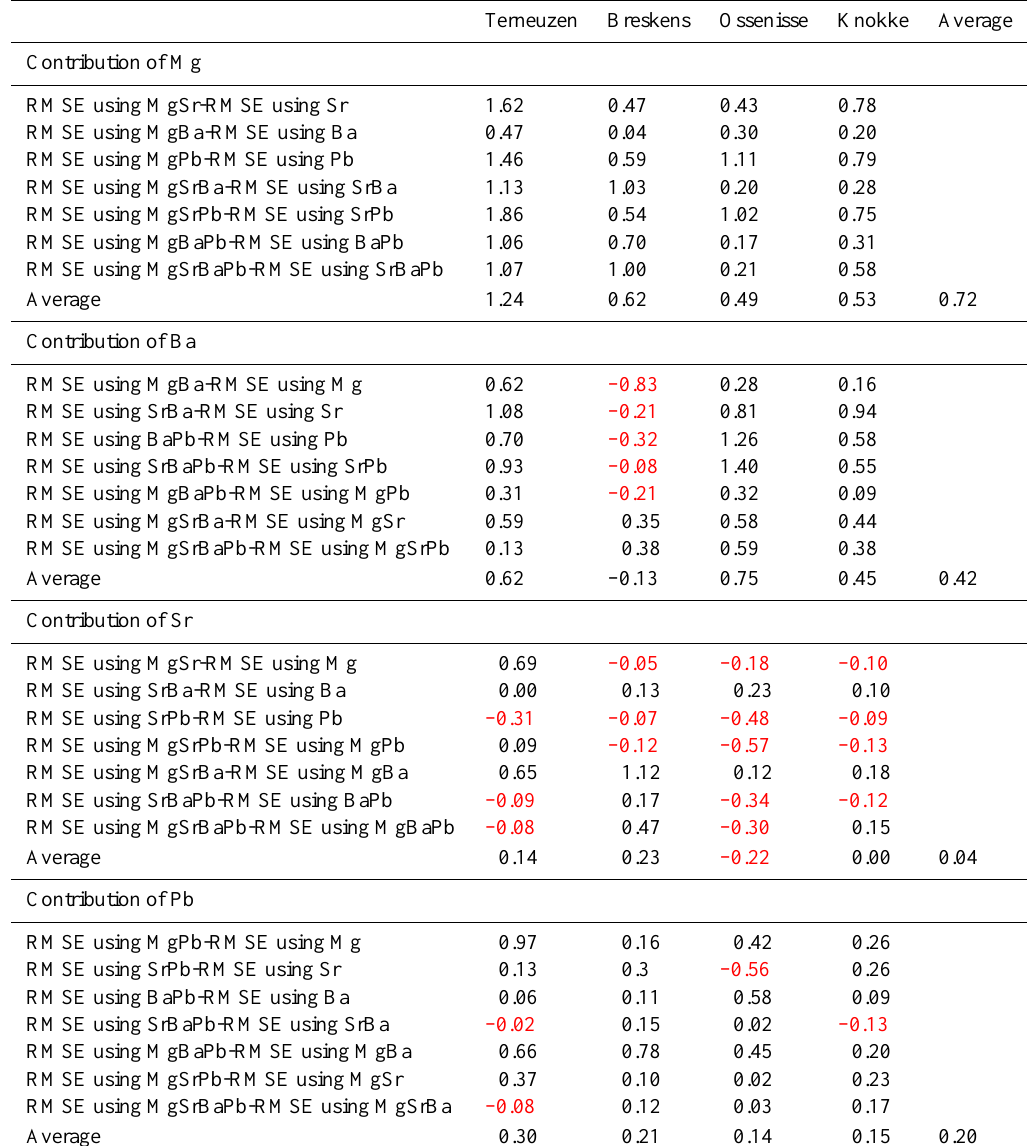
Table 1. Seven unique contribution factors are defined per proxy. Every contribution factor is defined by the difference between the RMSE of a model based on a proxy combination whith the investigated proxy and the RMSE of a model based on a proxy combination without the investigated proxy. The average contribution of each proxy is given per study site and for the total validation set. Negative contribution factors are marked in red and mean that the corresponding proxy does not contribute to a better